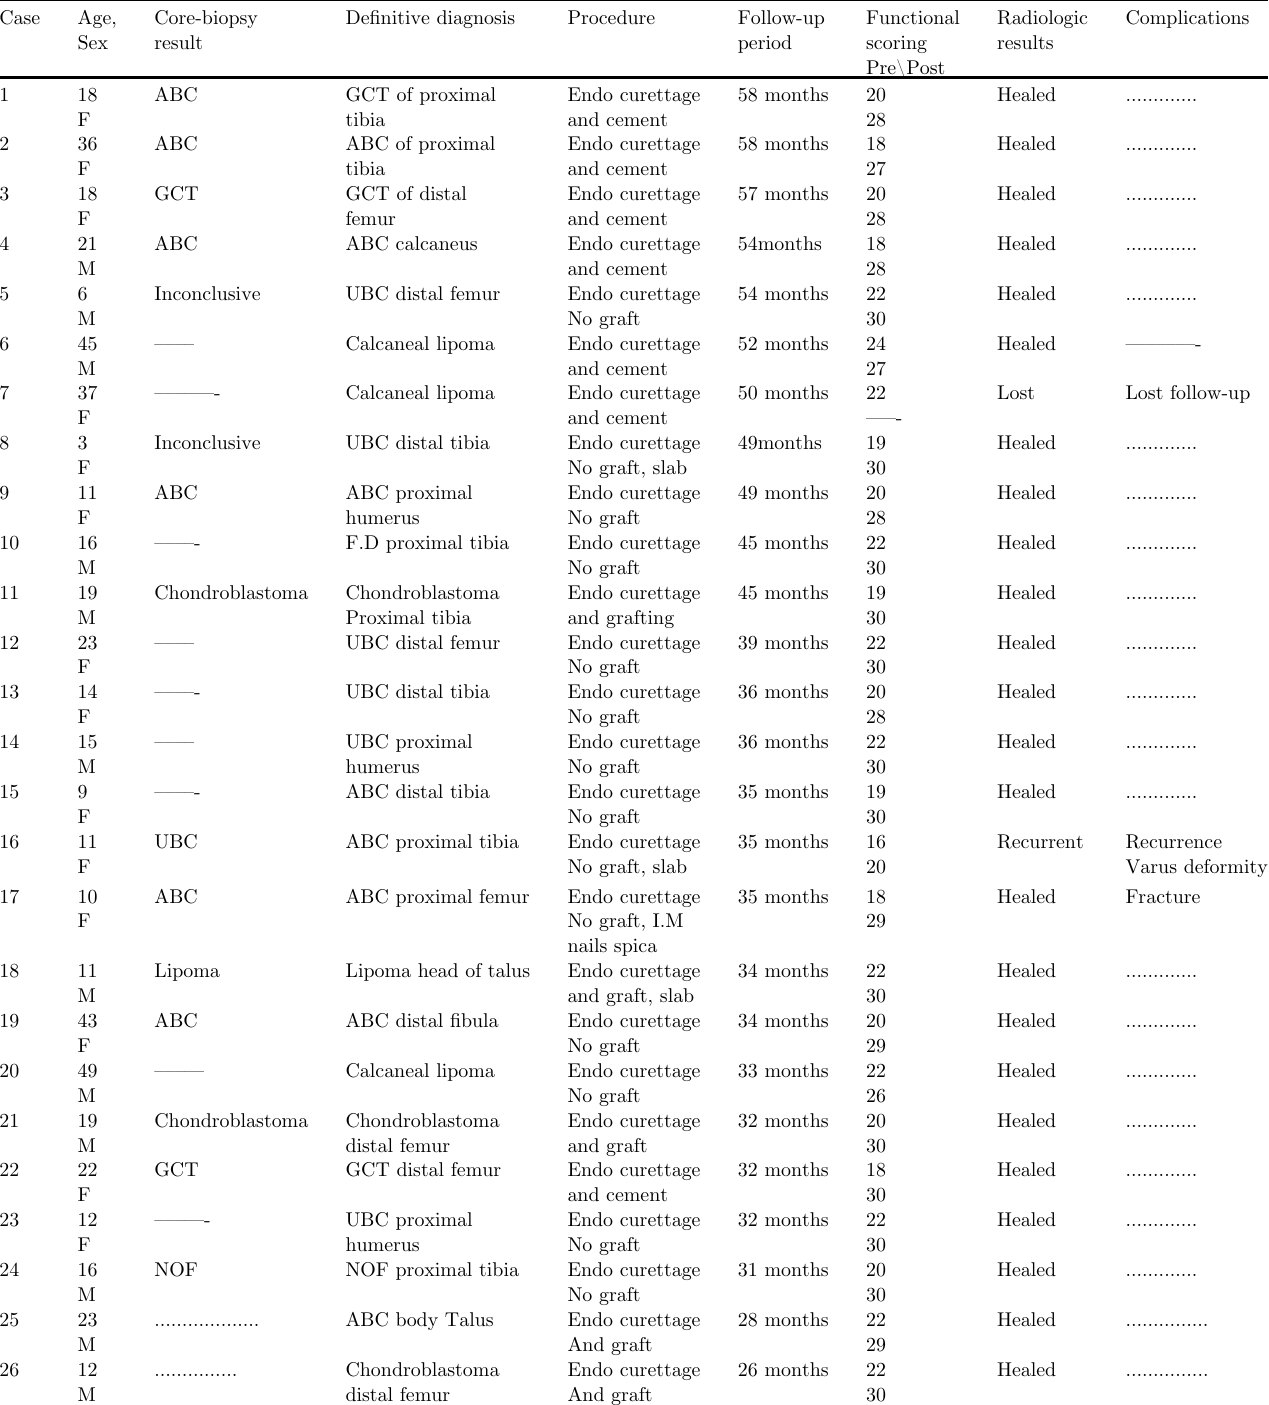
Table 3. Summary of the study